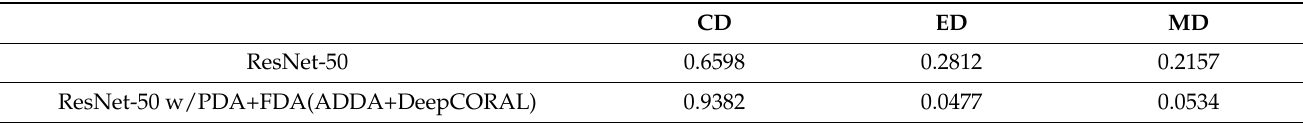
Figure 11. Examples of positive samples and negative samples: ( a ) wildland images of the cloud- smoke hybrid scenario; ( b ) non-smoke wildland images containing clouds or fog. Table 5. Comparison of model performance in the cloud-smoke hybrid scenario. Table 6. Average recognition time for a single image on different devices.